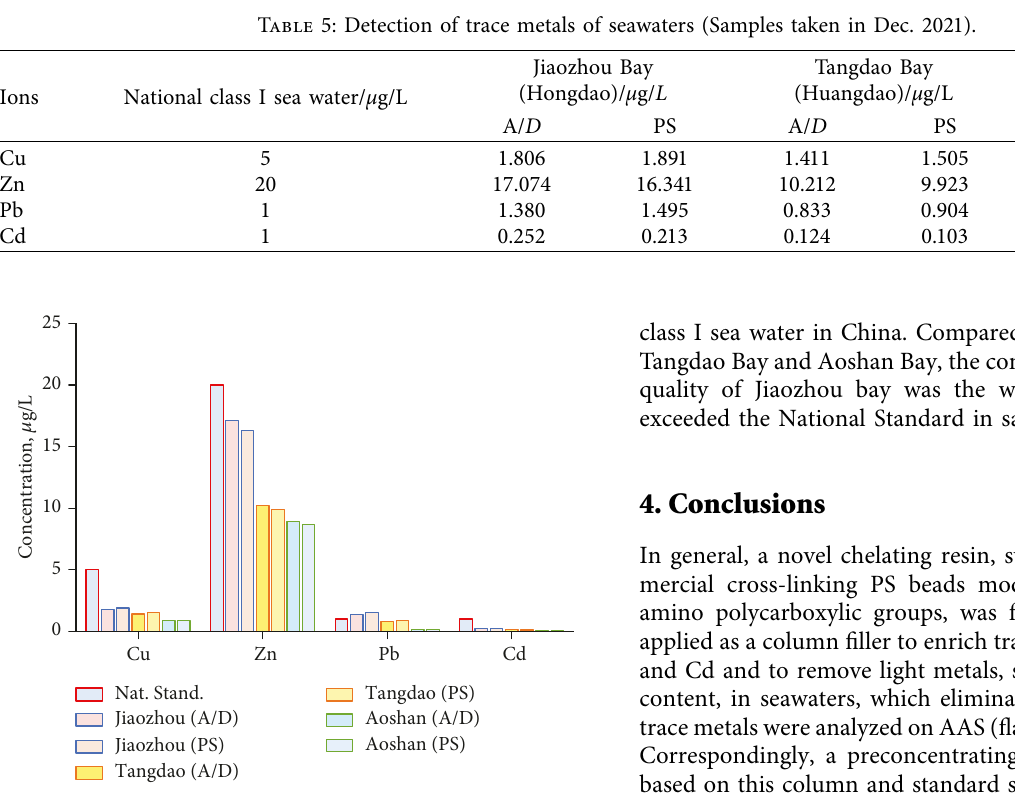
Figure 8: Actual measurement of seawater samples taken in three bays, Jiaozhou, Tangdao, and Aoshan, coastal sea of Qingdao, China, and conducting the enriching process for AAS to afford the concentration of Cu, Zn, Pb, and